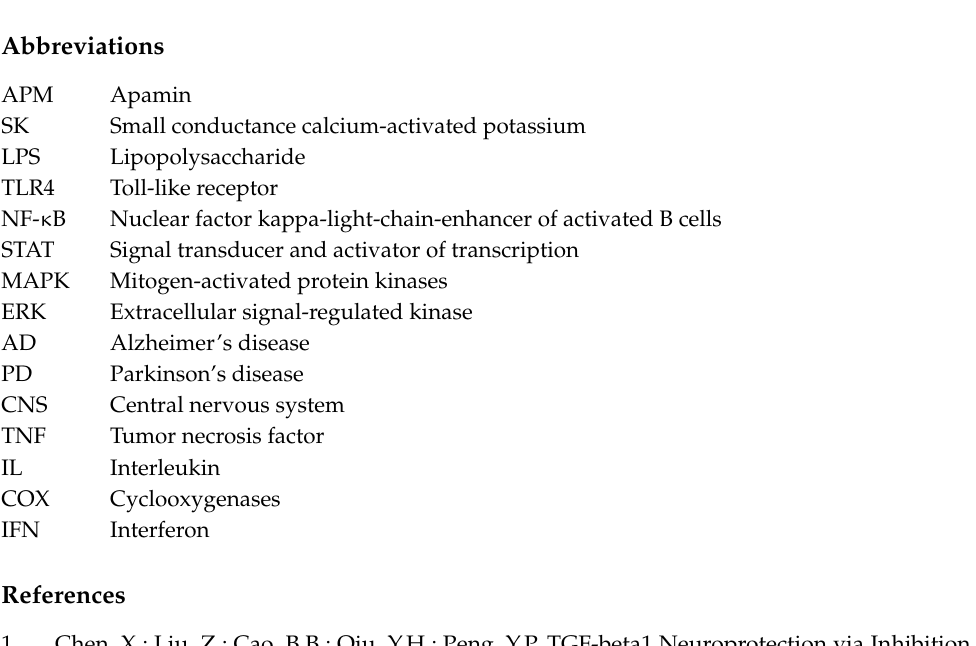
Figure S1: Increased inflammatory cytokines by LPS and cell viability of APM. Figure S2: E ff ect of APM on LPS-induced MAPK-JNK and p38 phosphorylation. Figure S3: Inhibitors of p65 (Bay11-7085), STAT3 (S3I-201), and ERK (SCH772984) inhibits LPS-induced CD11b, TNF α , TLR4, and pCaMKII expression in BV2 and rat primary microglial